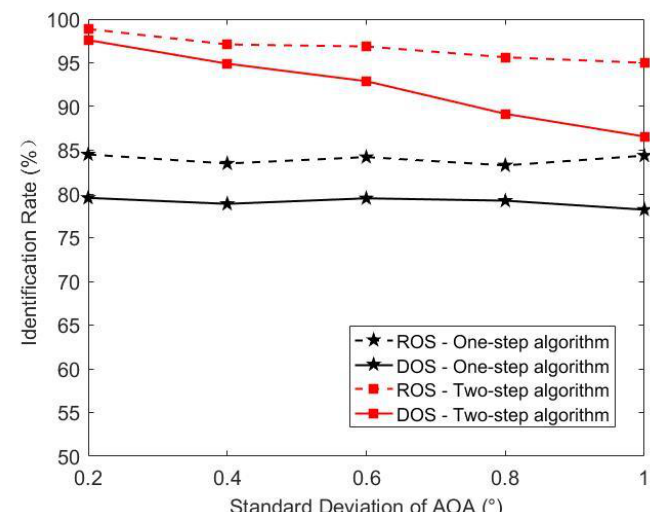
Figure 7. 𝑃 𝐼𝐸 versus 𝛿 𝐴 . Figure 7. P IE versus δ A .